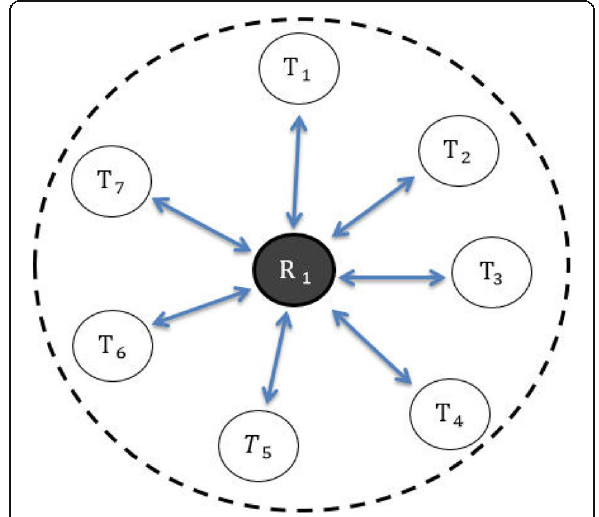
Fig. 4 Communication between cluster members and card reader